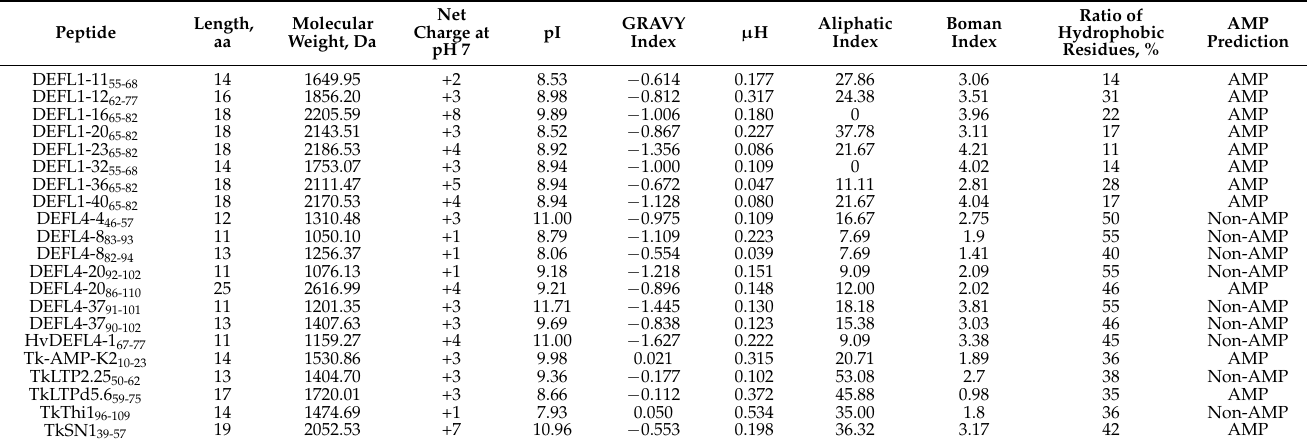
Table 1. Physicochemical properties of AMP-based synthetic